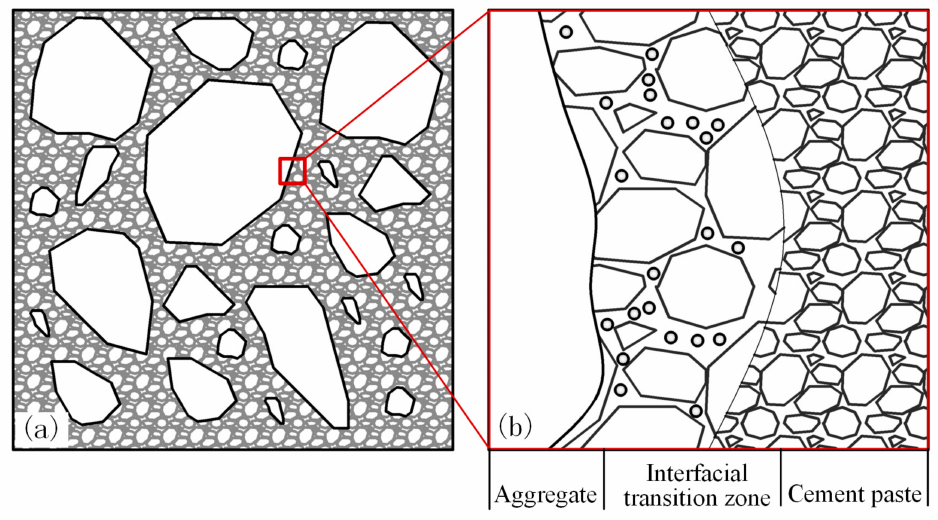
Figure 1. Composition of ordinary concrete structure ( a ) macrostructure; ( b ) submicrostructure.